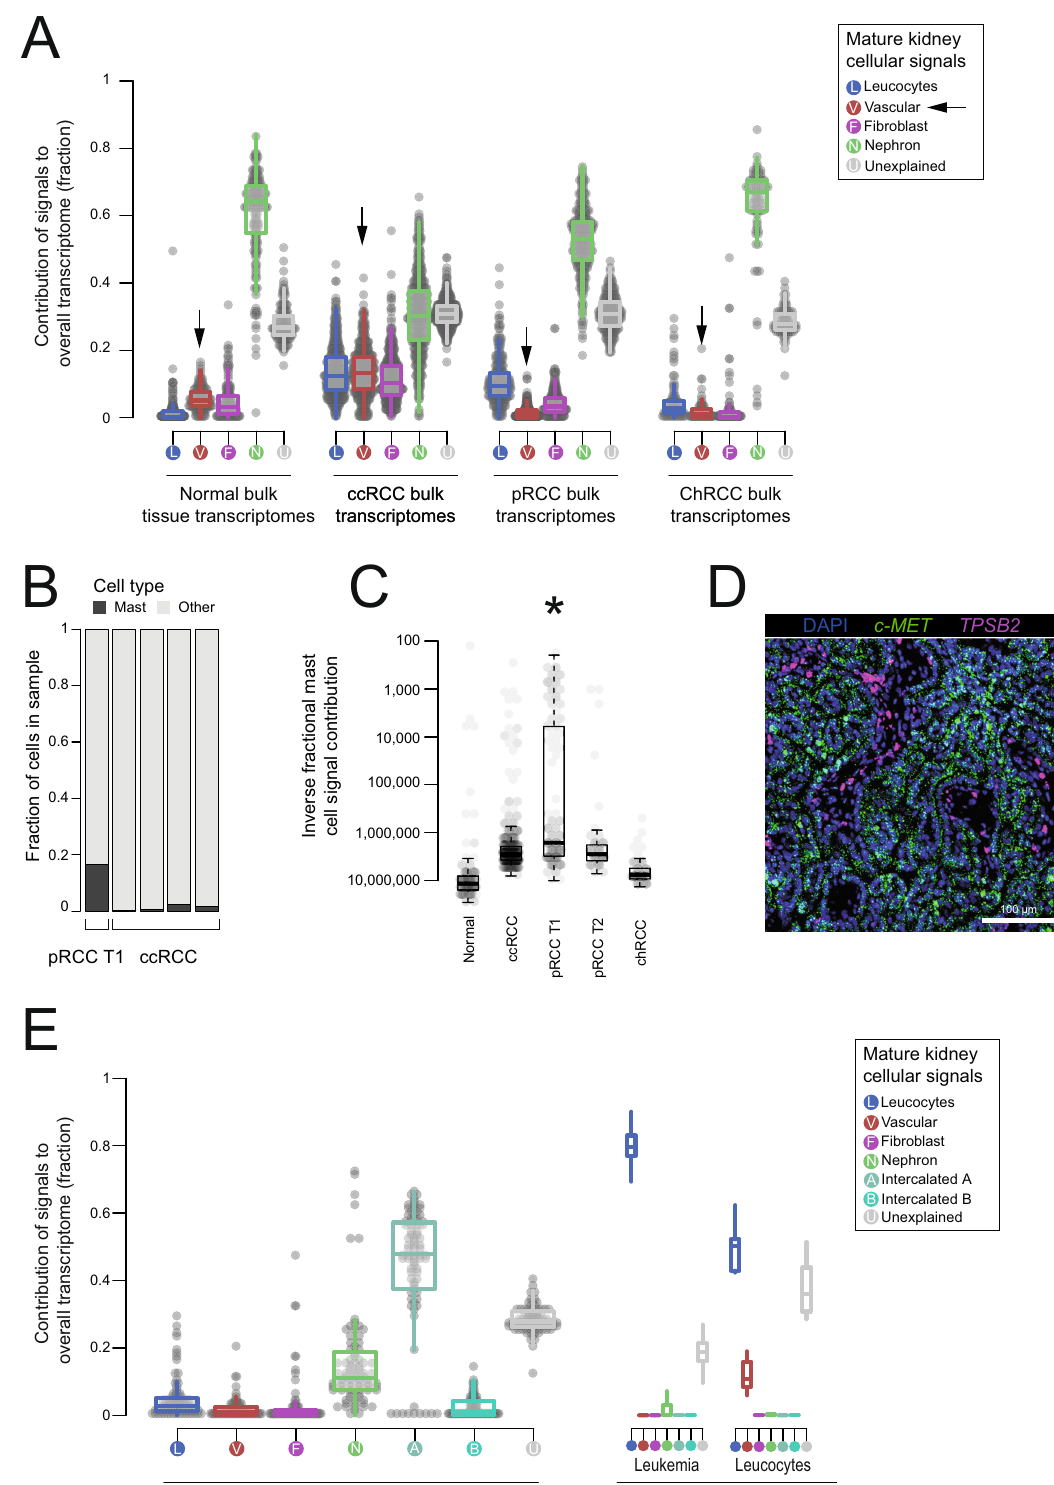
Annotation of fetal kidney single cell data . To create the fetal kidney reference, we combined the raw 10X output from previous studies 1,8 together with data from 4 additional fetal kidneys. The combined data were quanti fi ed and clustered as described above, with the exception that the clustering resolution parameter was set to 2 to obtain a more granular annotation. To annotate these clusters, we used a previously published detailed annotation of the fetal kidney as a reference 8 . That is, we fi rst trained a logistic regression model on just the “ PloS ” data 8 . In training this model we used the elastic net